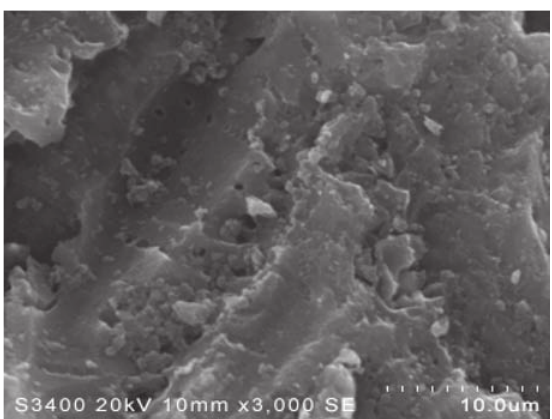
O on the sur- 2 3